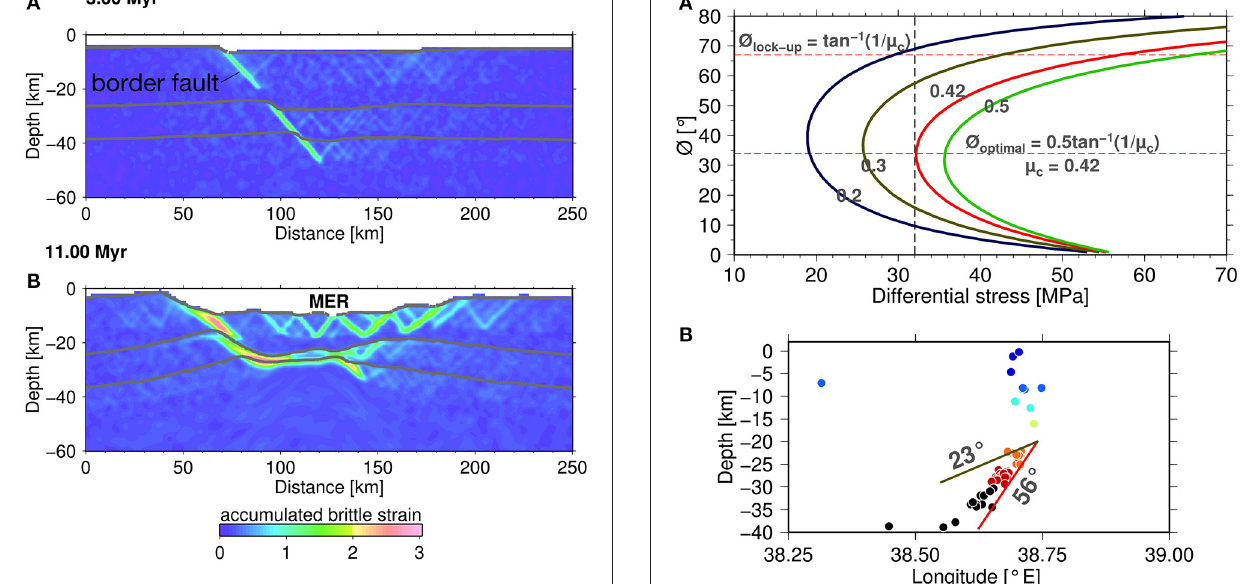
FIGURE 7 | Sequence of formation of faults in the MER (from Muluneh et al., 2020 ) at 3 Myr (A) and 11 Myr (B) after model initiation. The high pore fluid pressure can potentially reactivate faults in the lower crust.